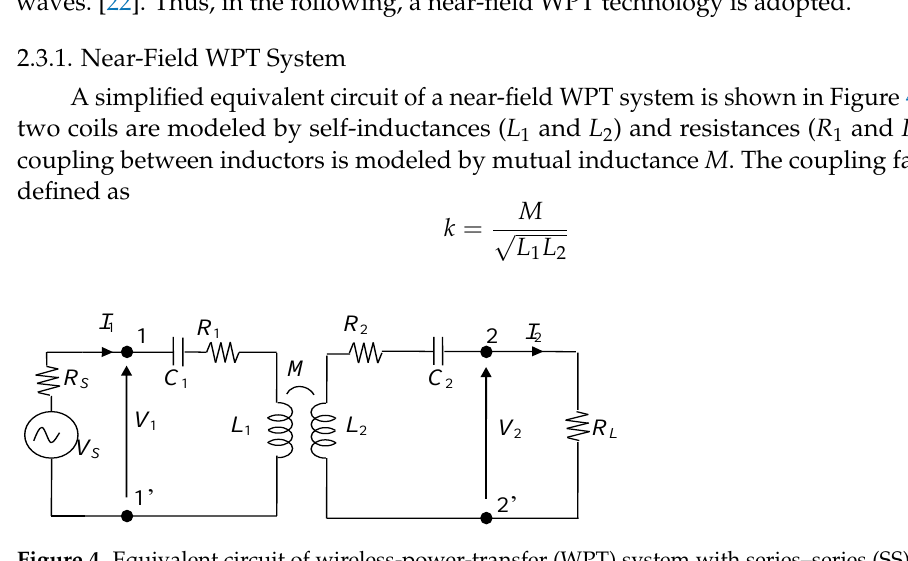
Figure 3. Measured transient hydraulic and electrical quantities (pressure, current, voltage, power).